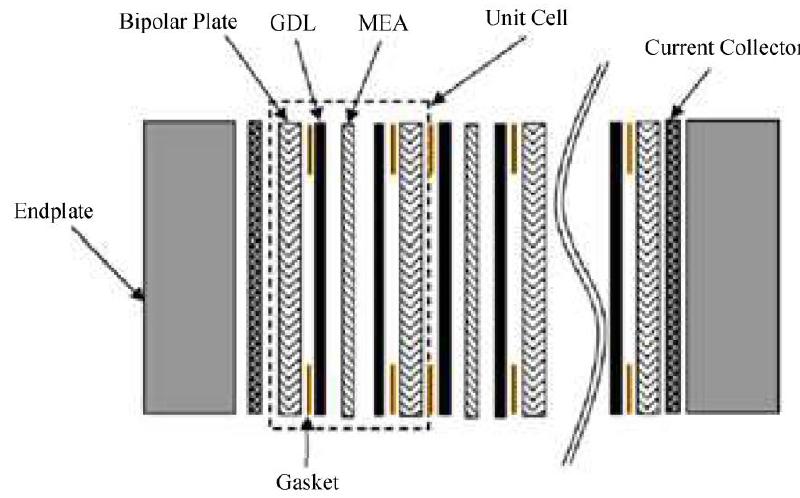
Figure 9. Schematic view of the PEMFC (adapted with permission from Ref. [45]).